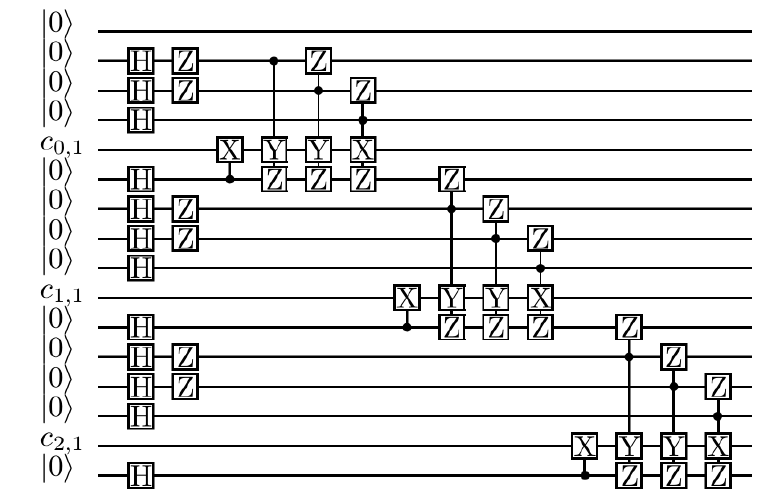
Figure 1. Circuit for encoding the first three qubits of a stream of quantum information with the 5-qubit convolutional